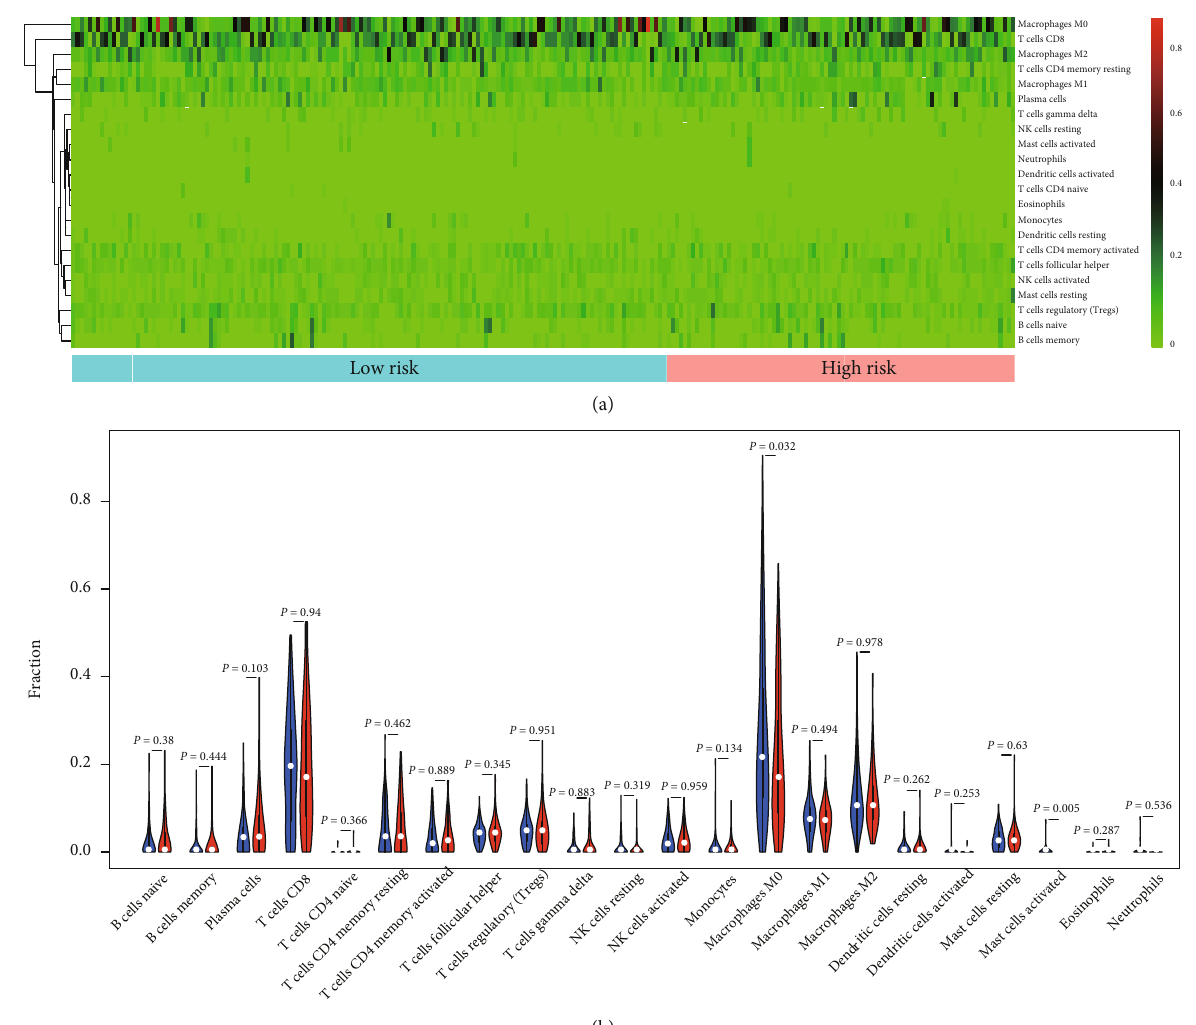
Figure 7: Di ff erential distribution of immune cells among the two groups. (a) Heatmap illustrating the di ff erences in in fi ltrating immune cells among the two groups. The colors ranging from green to red represent the in fi ltration density from low to high. (b) Wilcoxon rank-sum test was used to accurately compare the di ff erences, and results showed that M0 macrophages ( P = 0 : 032 ) and activated mast cells ( P = 0 : 005 ) in the high risk-group displayed a signi fi cantly lower in fi ltration